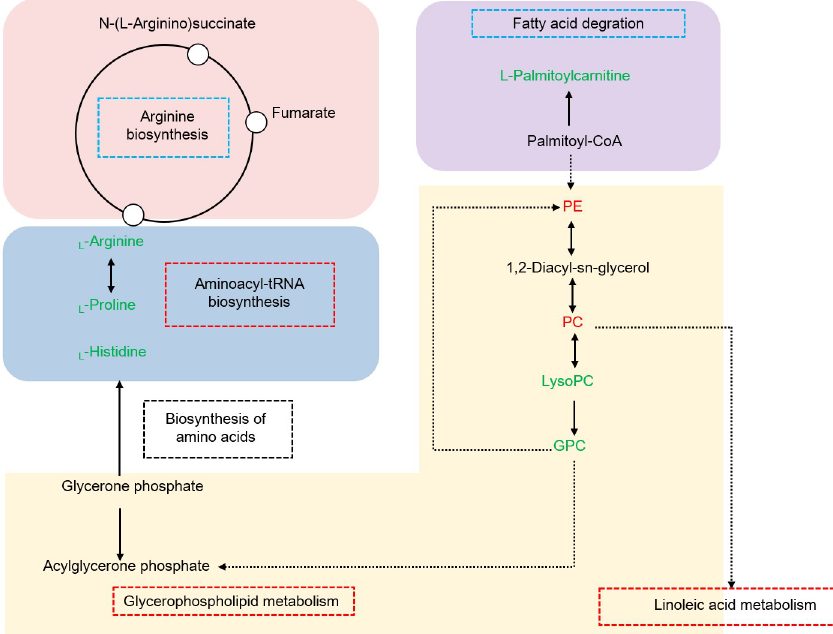
Fig 5. Hypothesized pathway of the different growth performances of M . rosenbergii . Up-regulated and down- regulated metabolites are shown in red or green letters. Three significant pathways are shown in red boxes, two pathways not significantly enriched are shown in blue boxes. Abbreviations: PE, PE (16:0/22:1(13Z)); PC, PC (14:0/ 18:1(9Z)); LysoPC, LysoPC (20:5(5Z,8Z,11Z,14Z,17Z)); GPC, Glycerophosphocholine.